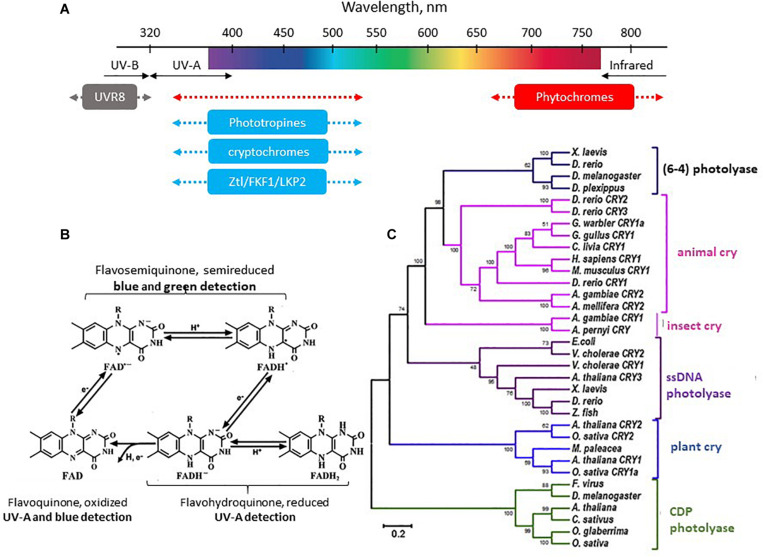
(A) The spectral sensitivity of plants. See text and (Huche-Thelier et al., 2016) for details. (B) Different states of the flavoquinone cofactor of Cry and corresponding photosensitivity (see text for details). (C) Phylogenetic tree of the photolyase/cryptochrome family. Modified from Du et al. (2014), with permission.